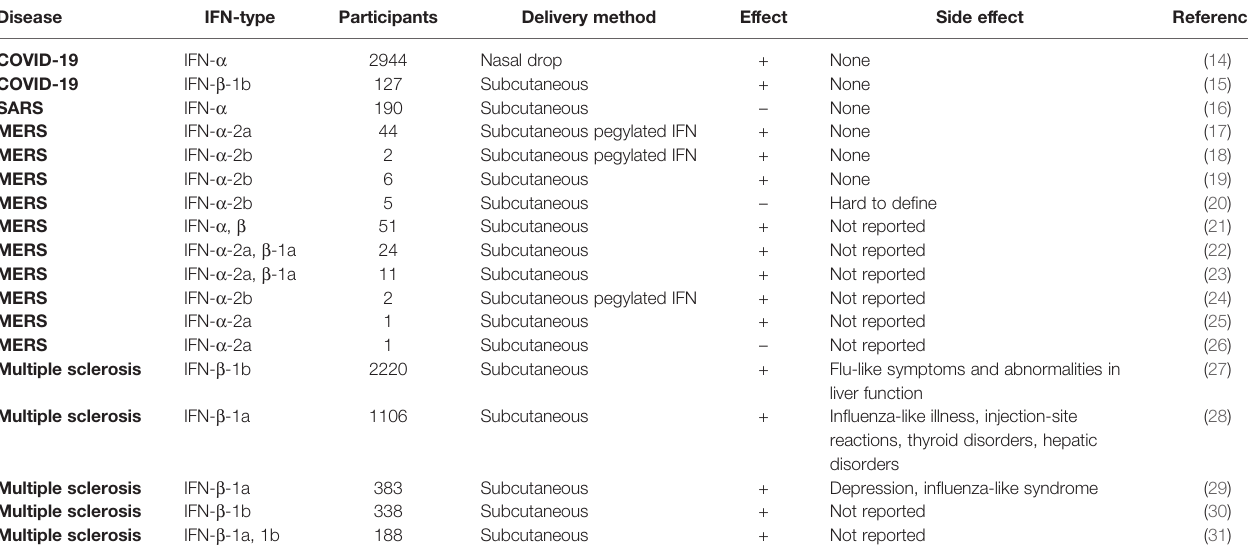
TABLE 1 | Clinical trials and results of IFN treatment.